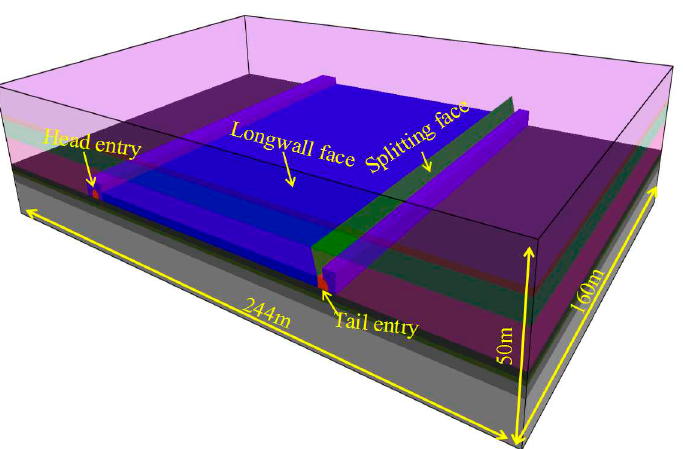
Figure 9. Three-dimensional numerical model of S204 coalface.